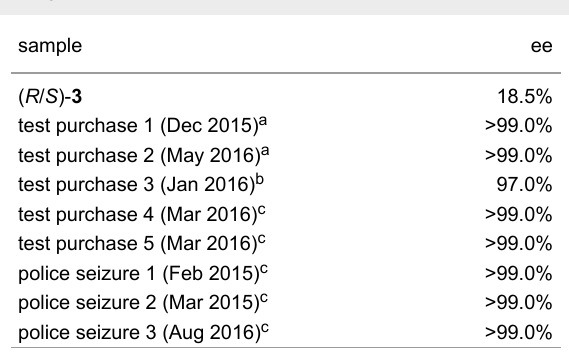
Table 1: Enantiomeric excesses of ( S )- 3 as determined by chiral HPLC.